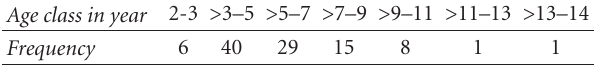
Table 2: Age distribution of subjects with Autism.